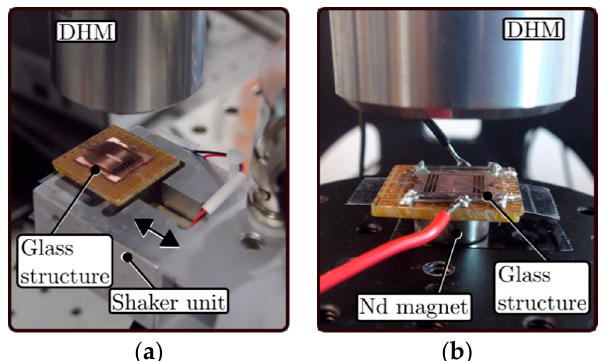
Figure 3. ( a ) The transducer is mounted on a piezoelectric driven shaker unit to characterise the structure’s transfer function. ( b ) Measurement setup for the Lorentz force excited structure, including a neodymium magnet with a magnetic field strength of 100 mT and current supply lines. The in-plane deflection of the transducer’s mass was measured with a Digital Holographic Microscope.